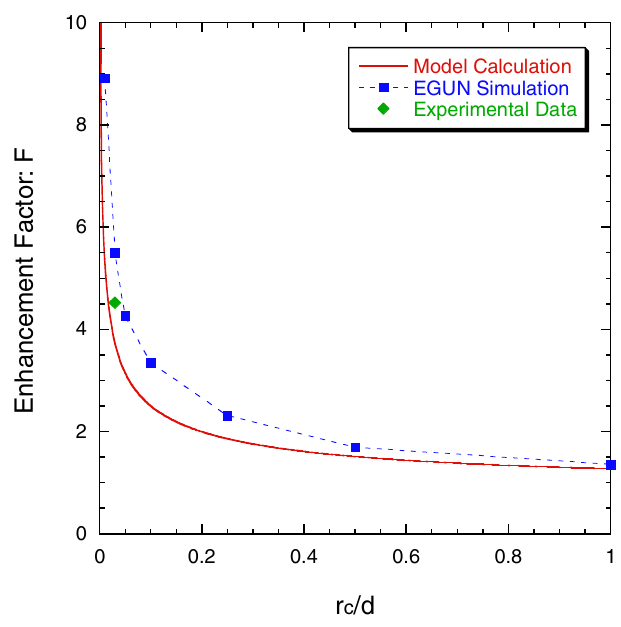
FIG. 14. (Color) Enhancement factor of space-charge limited current for flat electrodes as a function of the ratio of the cathode ) to the electrode gap ( d radius ( r c